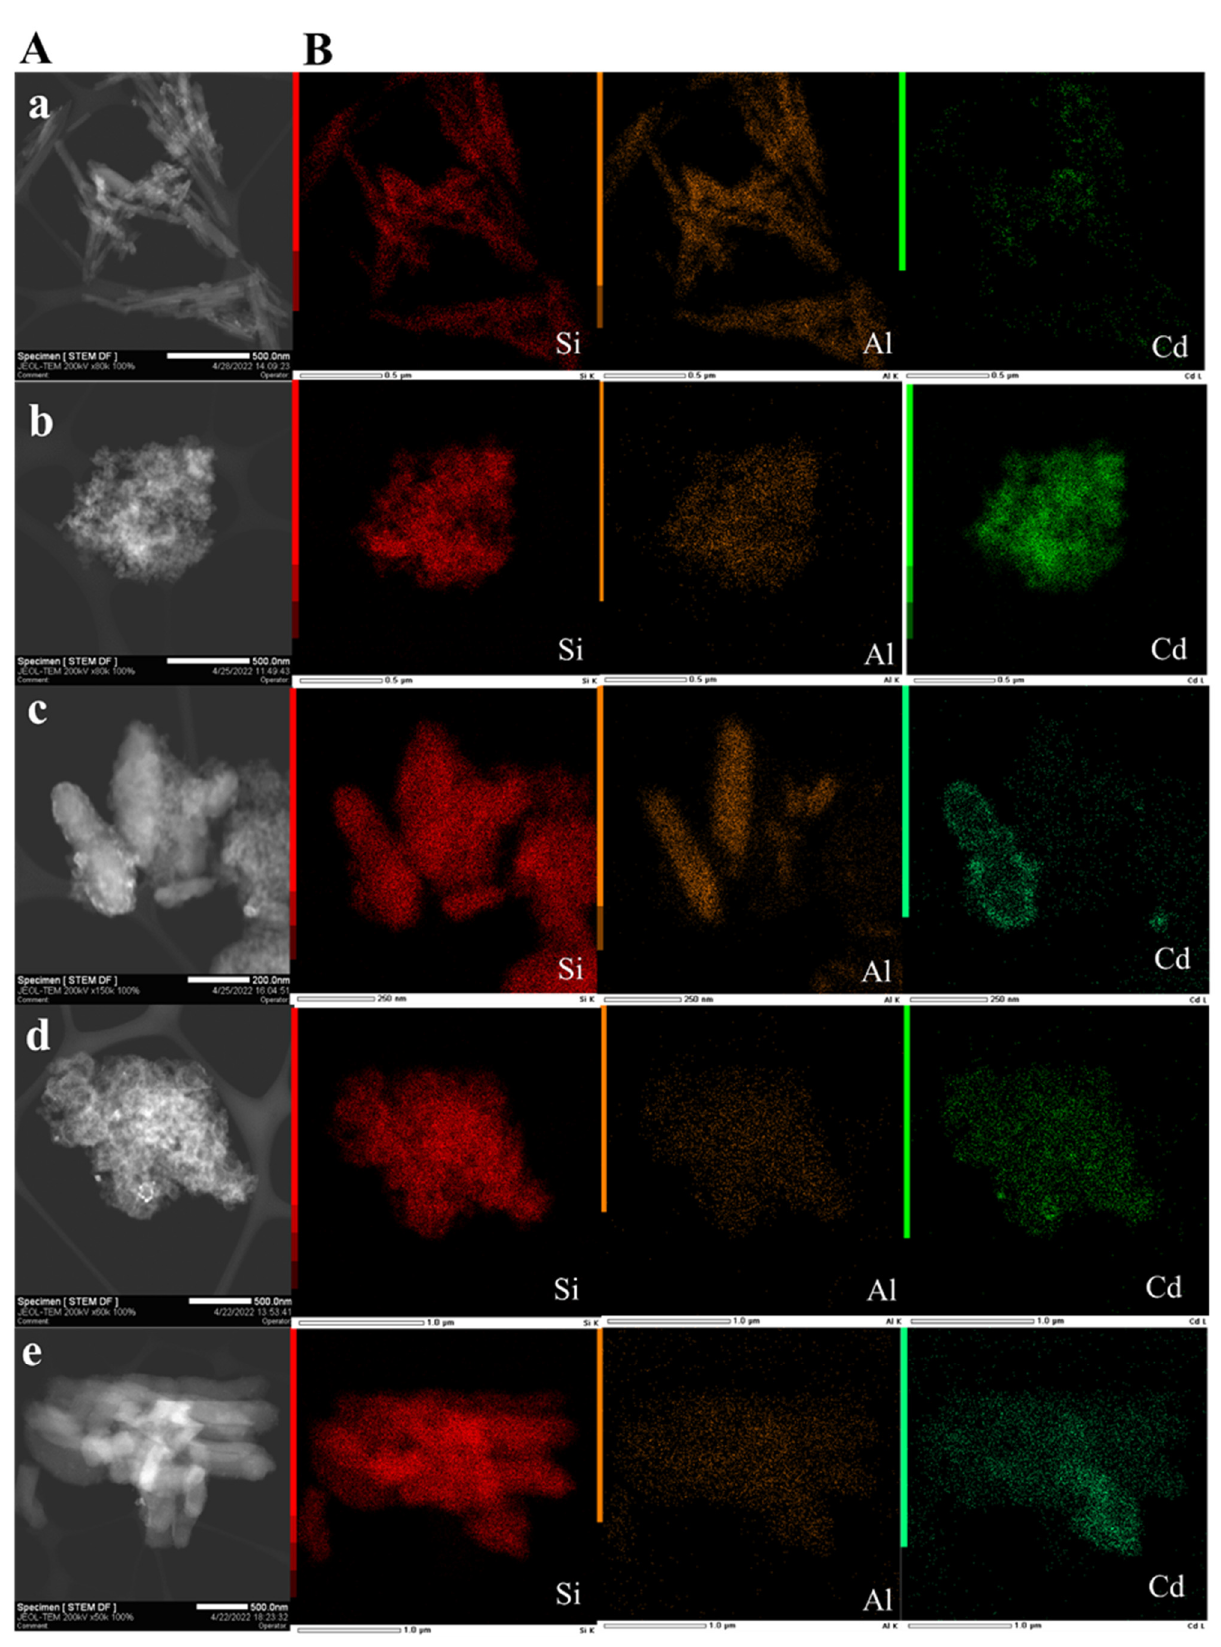
Figure 3. STEM ( A ) and elemental mapping ( B ) of CdS/HNTs ( a ), CdS/MCM-41 ( b ), CdS/MCM-41- HNTs ( c ), CdS/SBA-15 ( d ), CdS/SBA-15-SH ( e ).